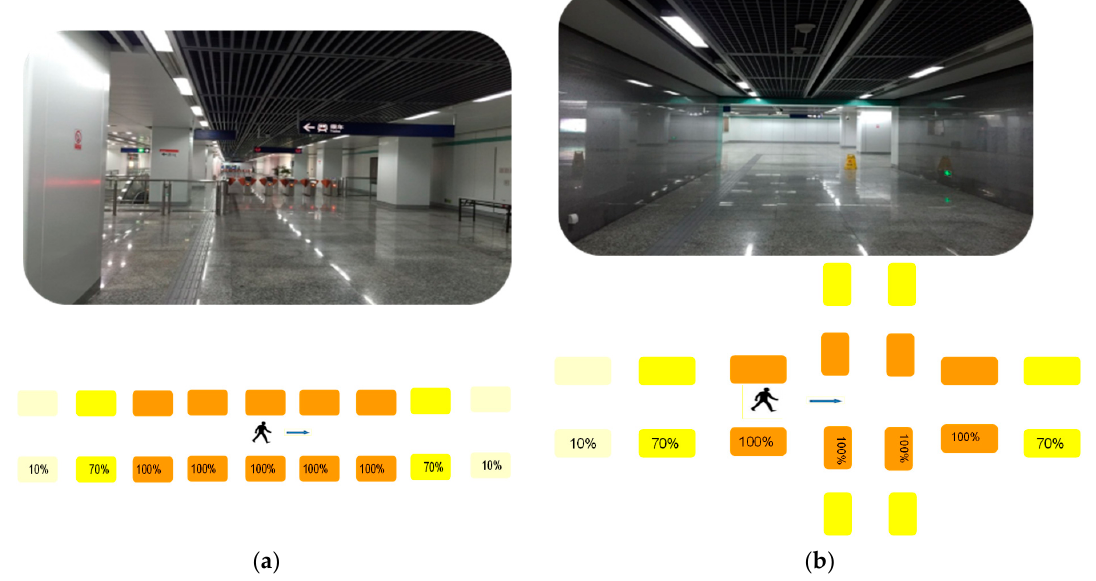
Figure 8. Two walking scenarios with lighting control strategies: ( a ) walking straight forward and ( b ) passing an intersection. Beyond the brightened area, the light-emitting diodes (LEDs) are at the dimming level of 10%.